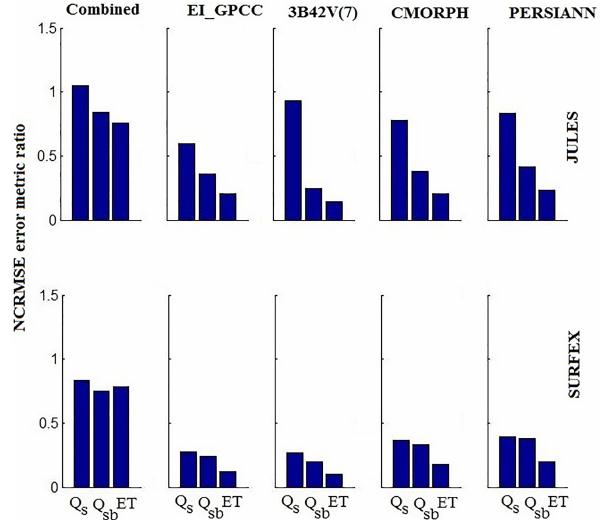
Figure 12. NCRMSE error metric ratios presented for the various products and models at 3-hourly scale.